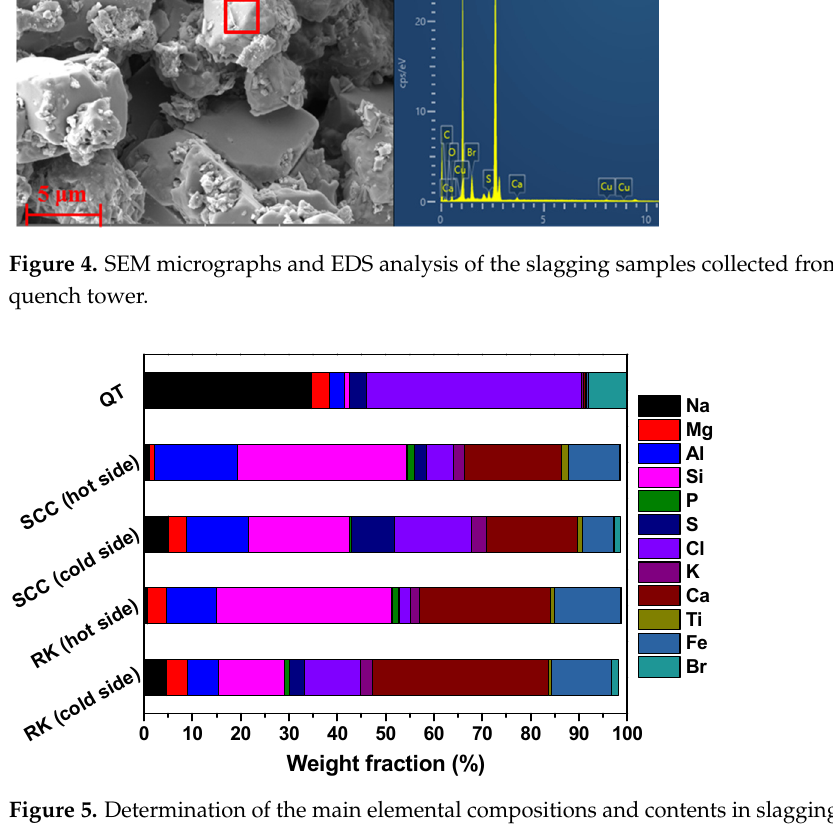
Figure 5. Determination of the main elemental compositions and contents in slagging samples by the XRF method.